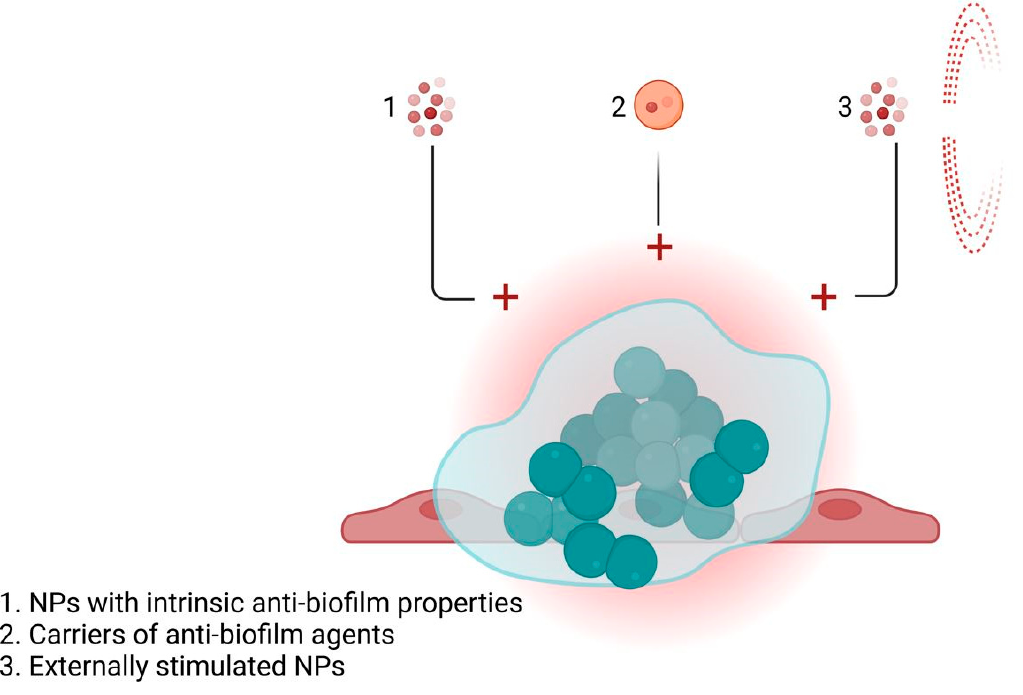
Figure 5. Nanoparticles for treating biofilm infections in the urinary tract.